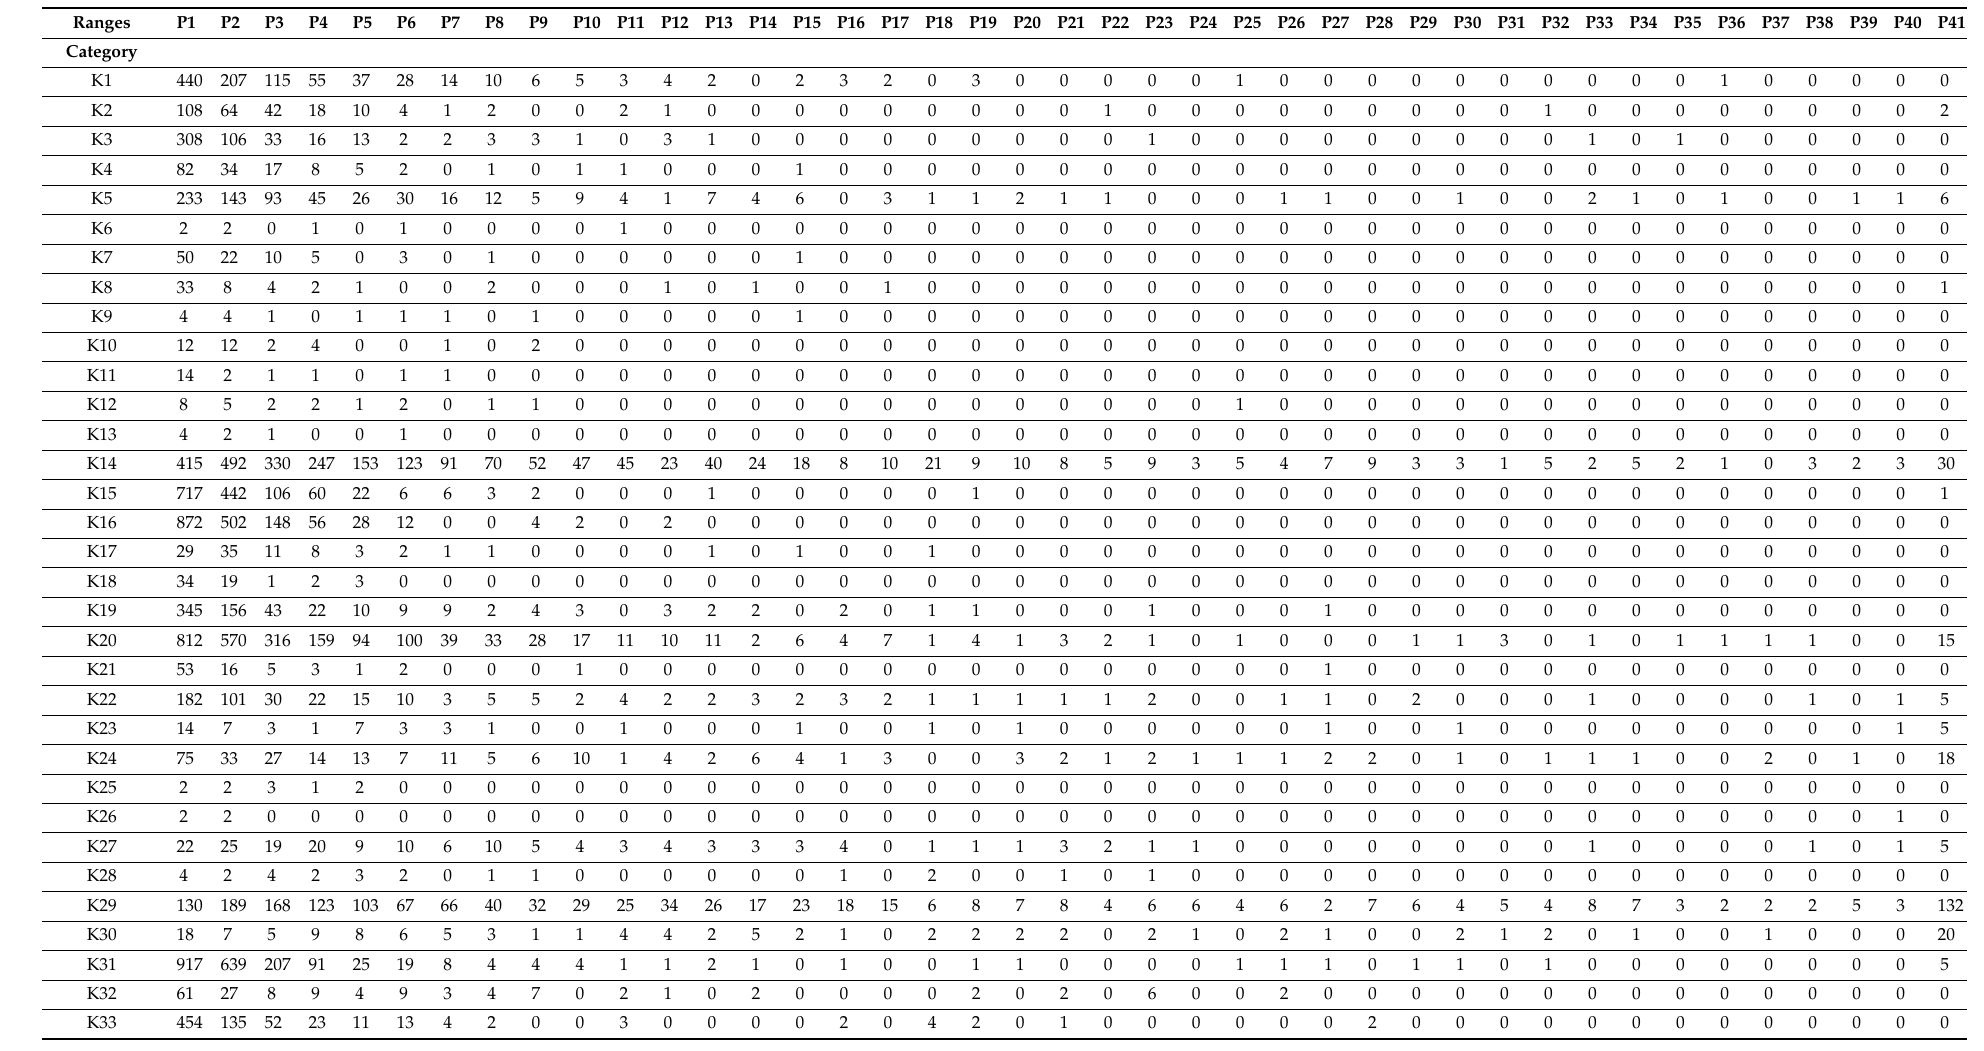
Table 5. Numerical input data in terms of the number of backers